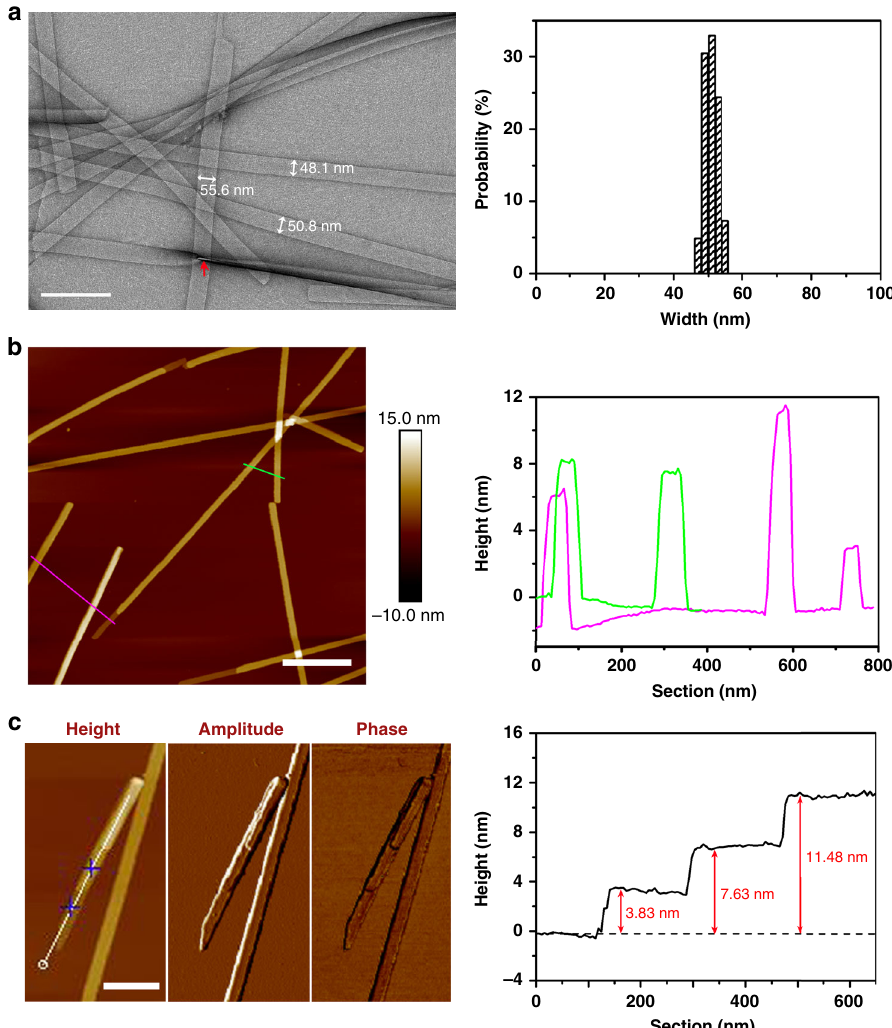
Fig. 2 Nanoribbons formed by 8 mM Ac-I 3 QGK-NH 2 at pH 7.0 after incubation for 1 week. a TEM micrograph (left panel) and width distribution histogram (right panel, based on measurements of ~100 individual ribbons). Scale bar, 200 nm. b Tapping-mode height AFM image (left panel) and representative cross-sectional height pro fi les (right panel). Scale bar, 500 nm. c Higher magni fi cation tapping-mode AFM images (left panel: height, amplitude, and phase) and a height pro fi le along the ribbon axis (right panel). Scale bar, 200